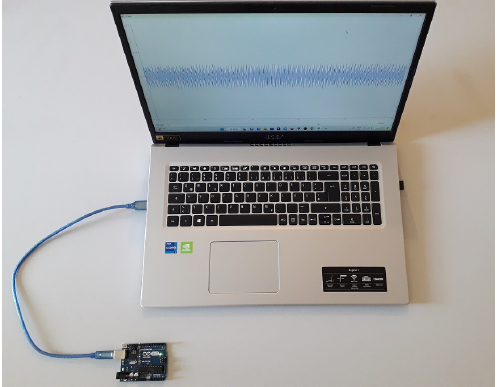
Figure 8. Arduino Uno board for realizing the FPFM 1 map is connected to a